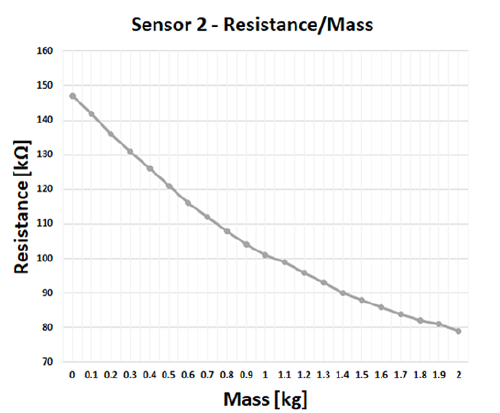
Figure 9. Measured resistance depending on the applied mass, for a given sensor